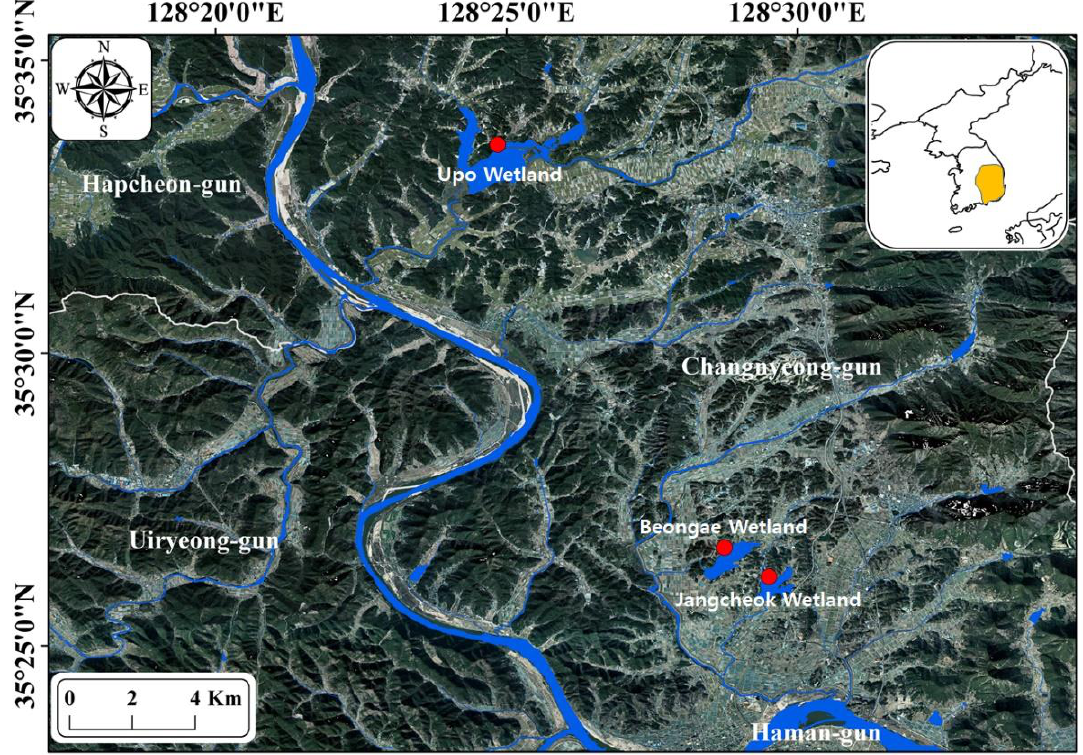
Figure 1. Study site locations. The study sites (Upo, Jangcheok, and Beongae wetlands) located in southeast South Korea are indicated by solid circles ( ● ). The small map in the upper right-hand corner shows the Korean Peninsula, and the Nakdong River is indicated in yellow.